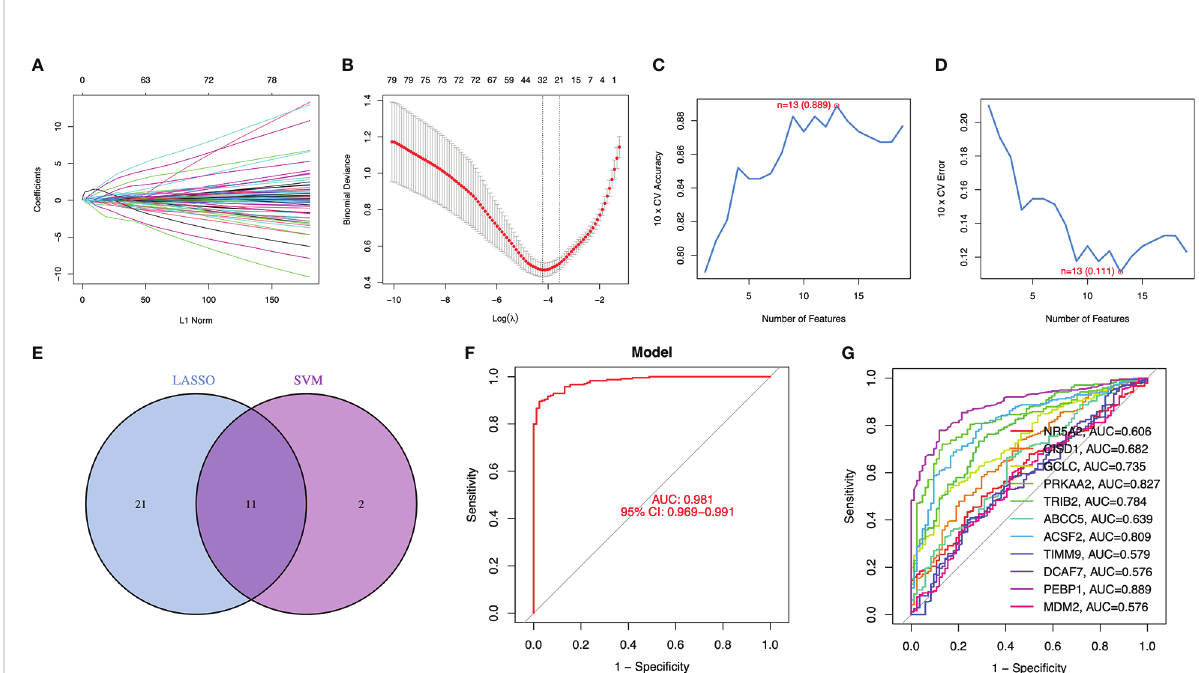
FIGURE 2 11 DE-FRGs were identi fi ed as diagnostic genes for psoriasis. (A, B) By LASSO logistic regression algorithm, with penalty parameter tuning conducted by 10-fold cross-validation, was used to select 32 psoriasis-related features. (C, D) SVM-RFE algorithm to fi lter the 13 DE-FRGs to identify the optimal combination of feature genes. Finally, 11 genes (maximal accuracy= 0.889, minimal RMSE= 0.111) were identi fi ed as the optimal feature genes. (E) The marker genes obtained from the LASSO and SVM-RFE models. (F) Logistic regression model to identify the AUC of disease samples. (G) ROC curves for the 11 marker